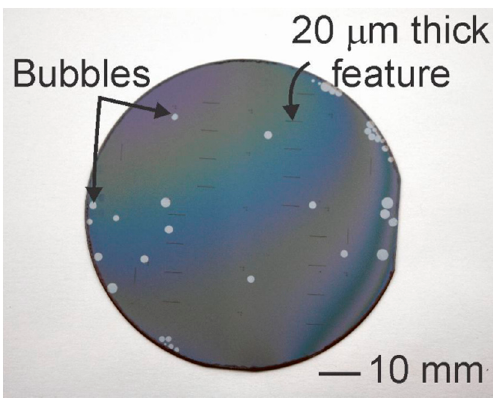
Figure 12. Observed gas bubbles in a Parylene coated wafer following UV exposure of a photoresist coating.